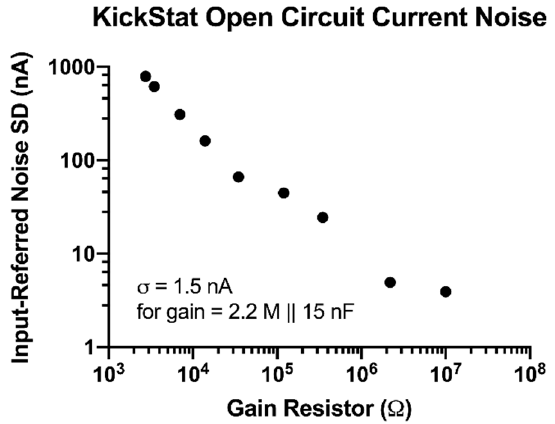
Figure 2. Open circuit current measurements with calculated input-referred noise. Noise decreases as the gain resistor increases.